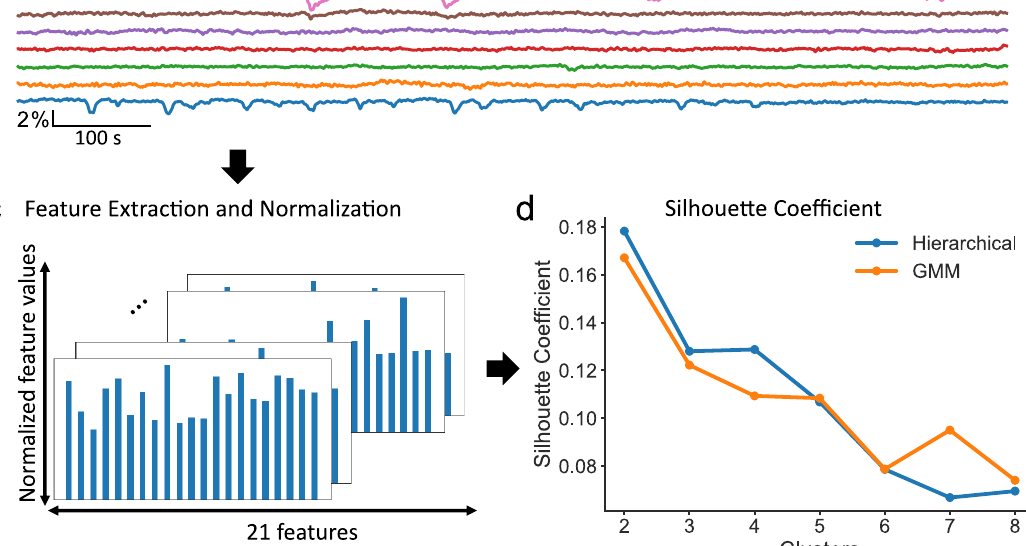
Fig. 4 The dynamic electrical signature (DES) of MDA-MB-231 cells clustered into four classes. a Time series were admitted to the unsupervised machine learning clustering pipeline if their temporally fi ltered Δ R / R 0 exhibited fl uctuations > 2.5× of their within-ROI pixel standard deviation from the median pixel value, and if also free of imaging artefacts including fl oating dust, mechanical vibration, and illumination edge effects. b Visual inspection of each cell ’ s time series fi nalized admission to the cellular DES pipeline. c 22 features relevant to time series temporal patterns were extracted from each time series using the Catch-22 algorithm 32 and normalized with a Box-Cox transformation relative to their values. d The silhouette coef fi cients for different cluster numbers were generated through hierarchical clustering (blue) or gaussian mixture modeling (GMM, orange) on the normalized